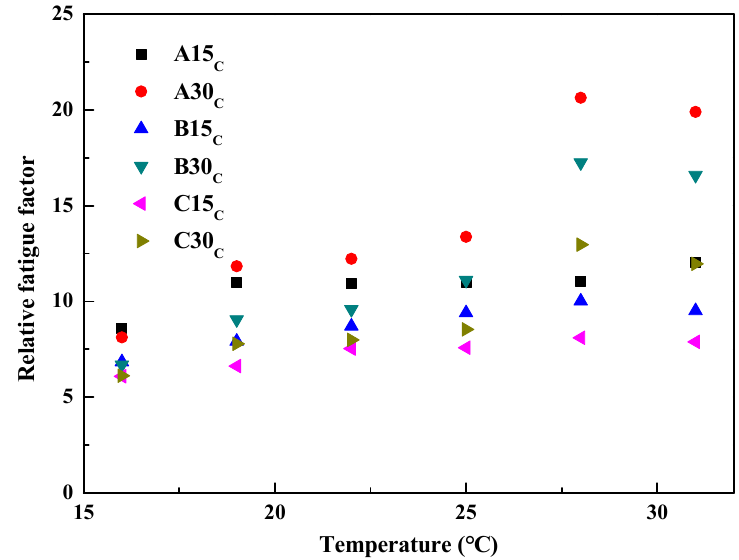
Figure 8. Variation of Δ G*sinδ for reclaimed asphalt versus temperature.